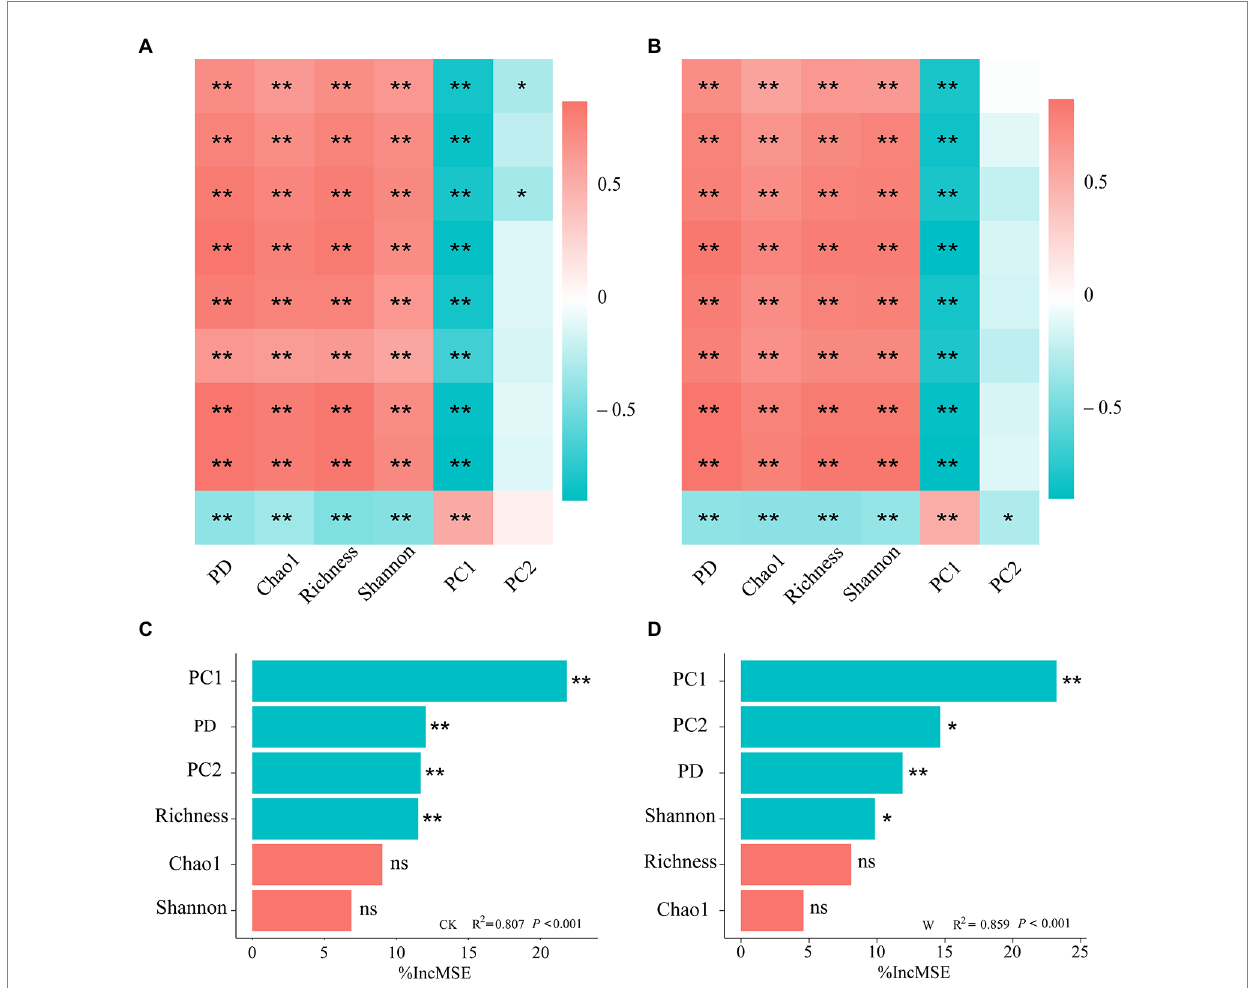
FIGURE 2 The correlation between nutrient variables and the diversity of bacteria in the alpine ecosystem. Heatmaps of the Spearman’s correlation coefficients between community diversity and individual nutrient variables under control (A) and warming (B) . * p < 0.05; ** p < 0.01. The importance of bacterial α -and β -diversity driving the cycling of soil multi-nutrient in the entire profile under control (C) and warming (D) , was assessed by RF